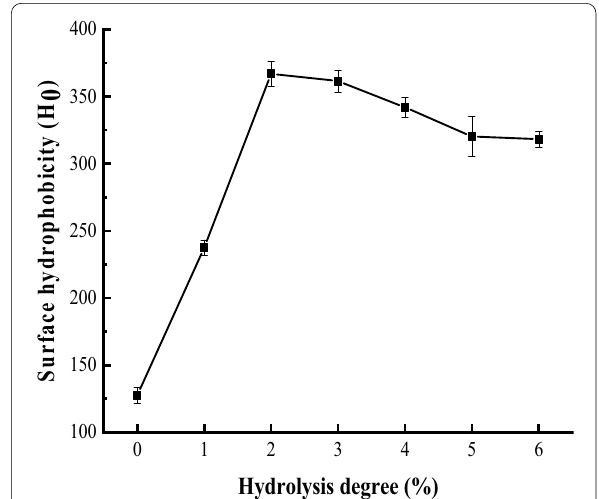
Fig. 2 Surface hydrophobicity of SPH at 0–6% DH, respectively